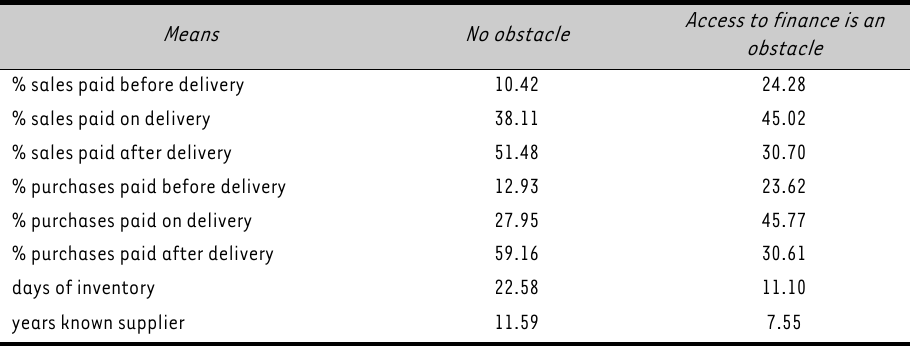
TABLE 3: Sales and supplies comparison of firms Means No obstacle